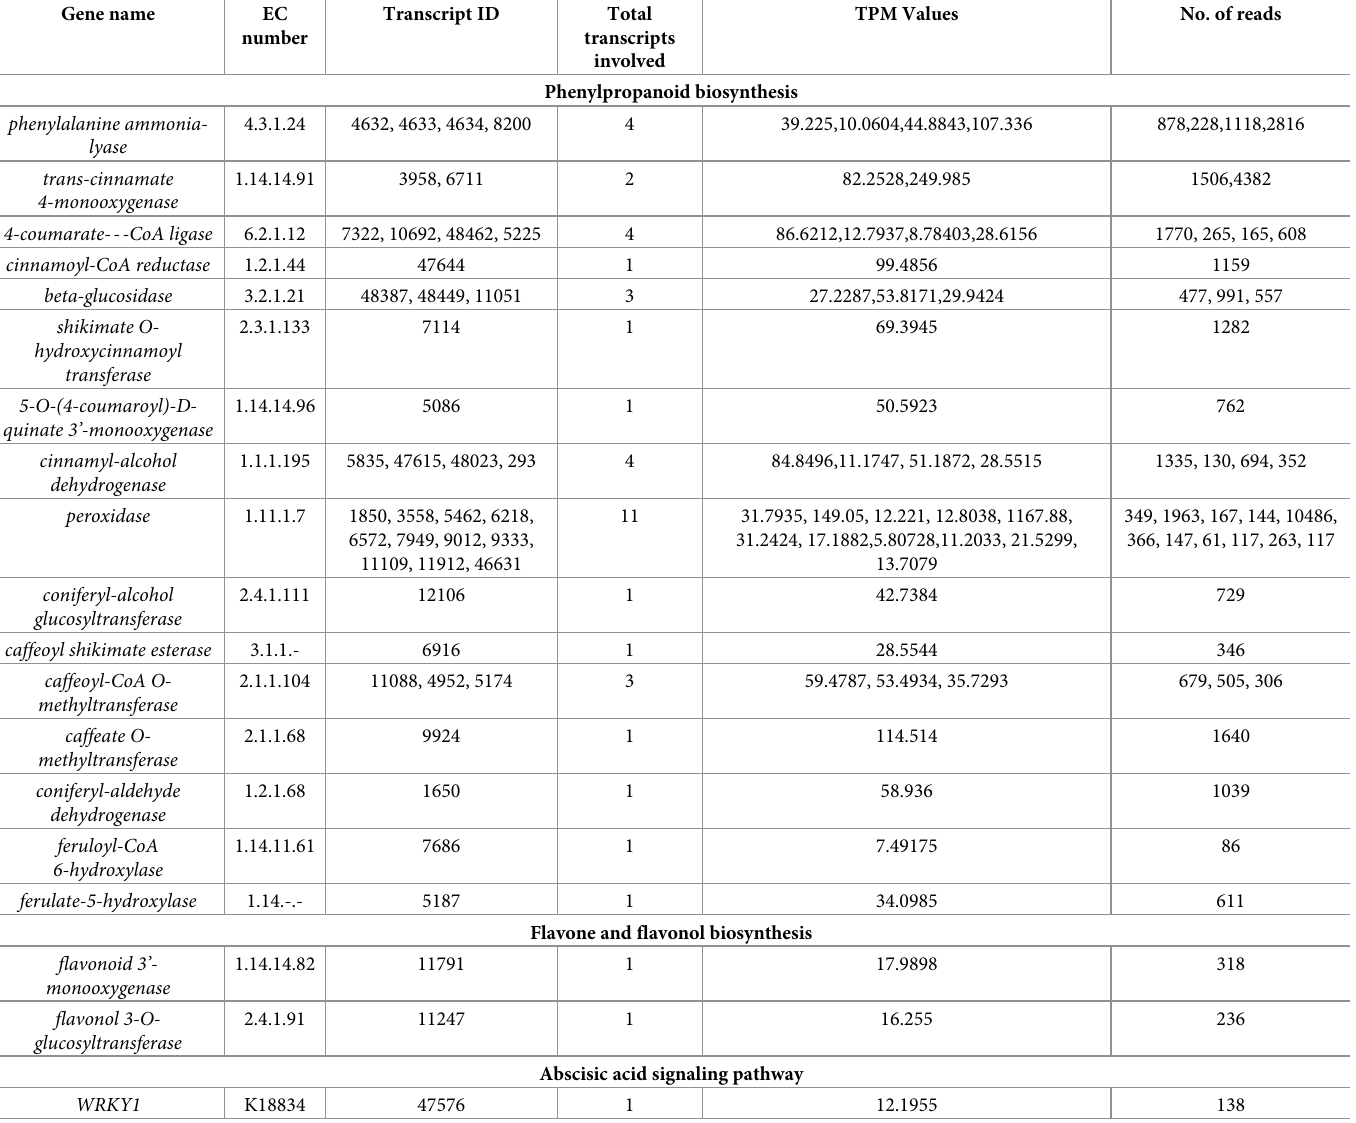
Table 1. The identification of genes involved in phenylpropanoid biosynthesis, along with their TPM